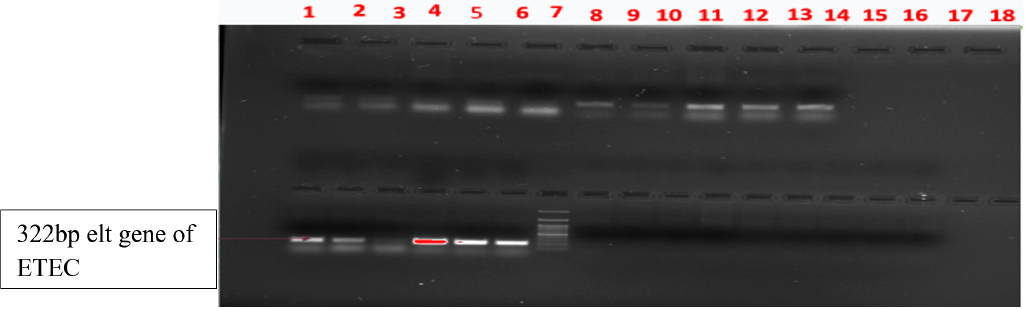
Fig. 2. Lane: 1, 2, 4, 5 and 6 contains elt gene of 322bp of ETEC gene and Lane 7 contain ladder